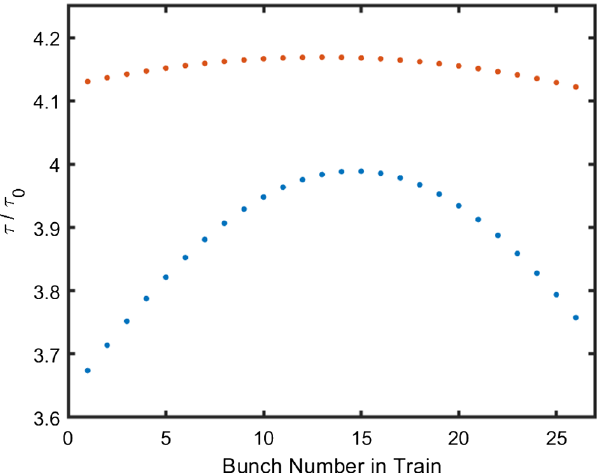
FIG. 8. Touschek lifetime increase along a train, with compen- sated MC (blue) and without (red). I